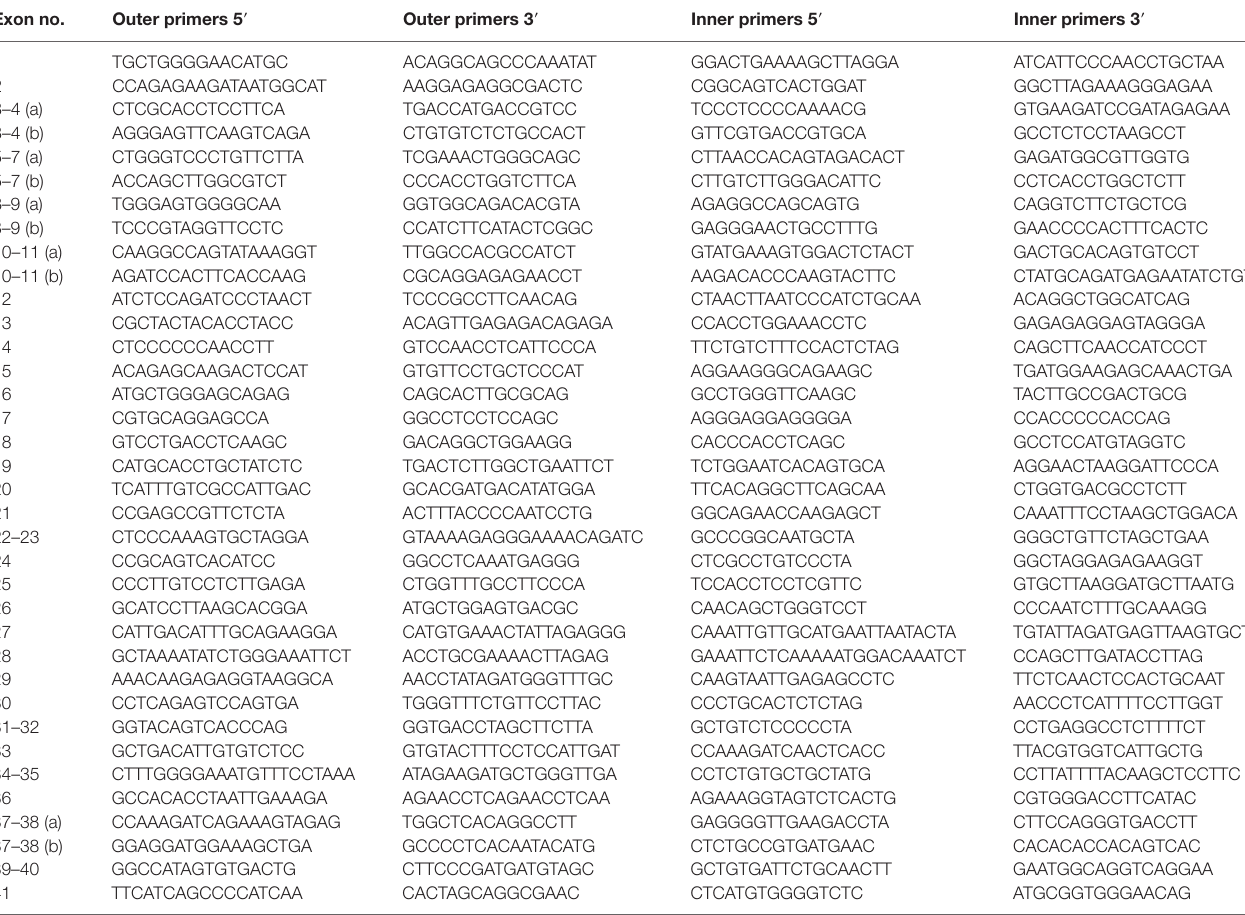
TaBle 1 | Primers used for sequencing of all C3 exons.